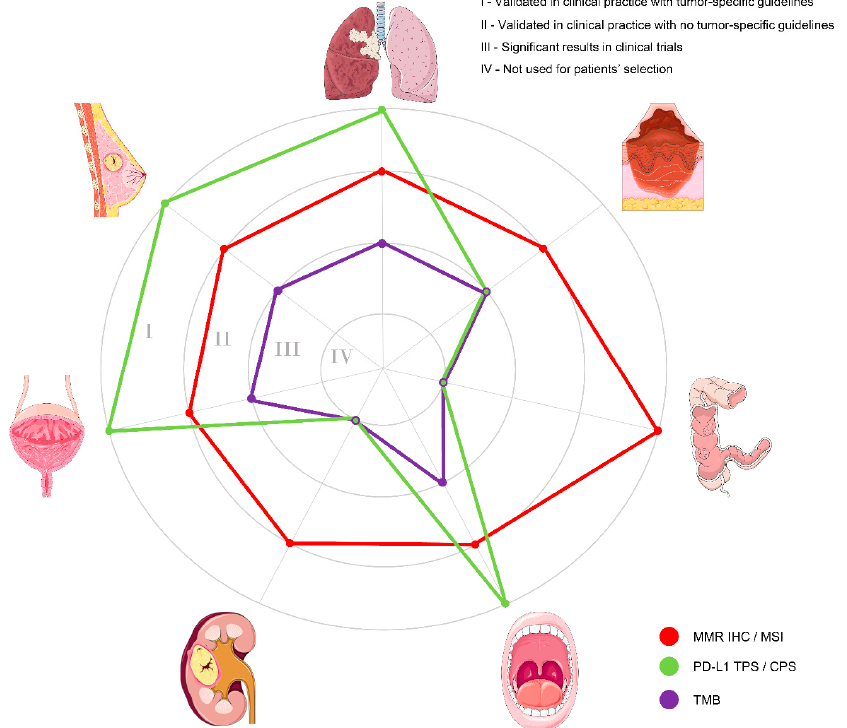
Figure 1. Schematic representation of the main tools available for patients’ selection for immunotherapy, according to the different anatomical sites. Clockwise from the top: non-small cell lung cancer, cutaneous melanoma, colorectal cancer, head and neck squamous cell carcinoma, renal cell carcinoma, urothelial carcinoma, and breast cancer. Each circle represents a level of validation of the various tools, as reported on the top right. The diagnostic tests are color-coded on the basis of the legend on the bottom right. MMR, mismatch repair; IHC, immunohistochemistry; MSI, microsatellite instability; PD-L1, programmed cell death ligand 1; TPS, tumor proportion score; CPS, combined positive score; TMB, tumor mutational burden.